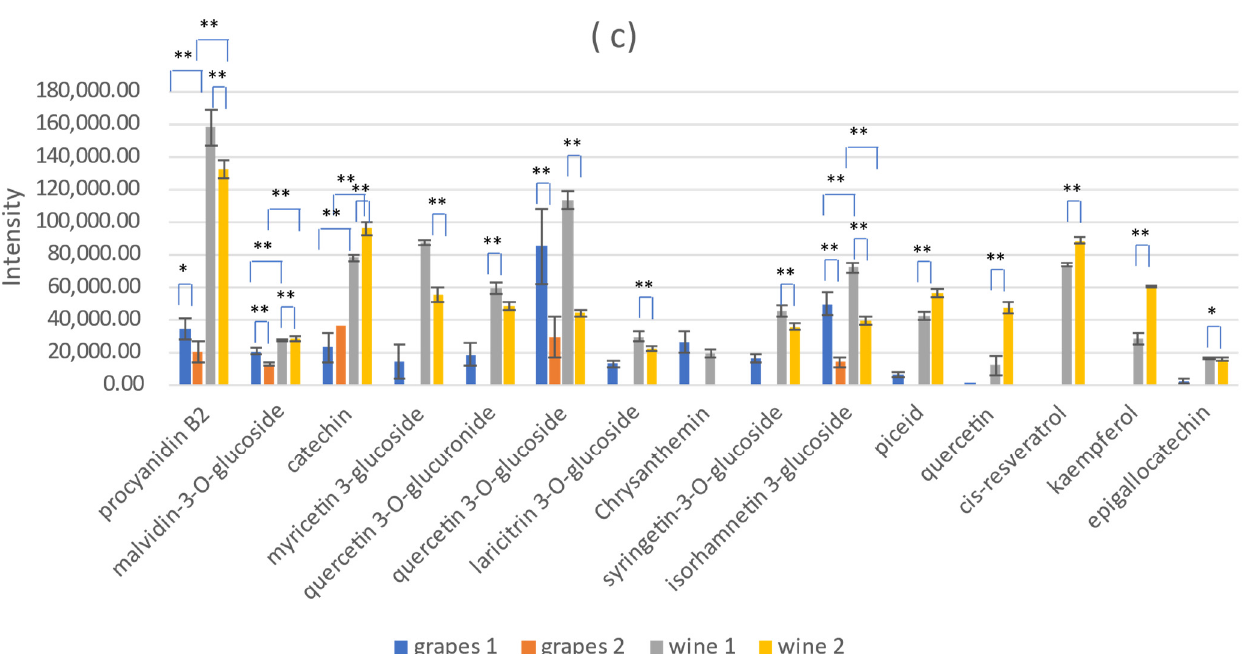
Figure 4. Quantification of compounds present in the samples from site 1 (grapes 1 and wine 1) and site 2 (grapes 2 and wine 2): ( a ) glucose and organic acids; ( b ) phenolic acids and their derivatives; ( c ) phenolic compounds (*; **—differences at the 95% and 99% significance levels, respectively). Compound appearing as 4-methoxyphenyl 4-O-(b-…) corresponds to 4-methoxyphenyl 4-O-(b-D- galactopyranosyl)-b-D-glucopyranoside.